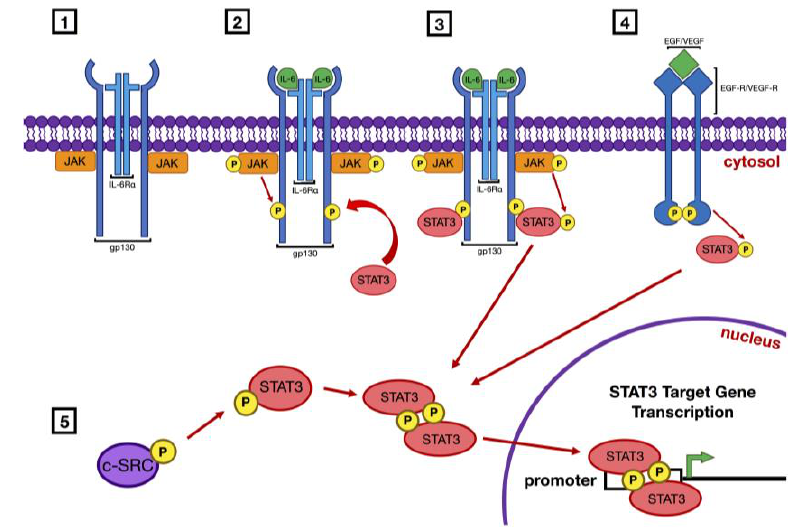
Figure 1. Pathways of signal transducer and activator of transcription 3 (STAT3) activation.